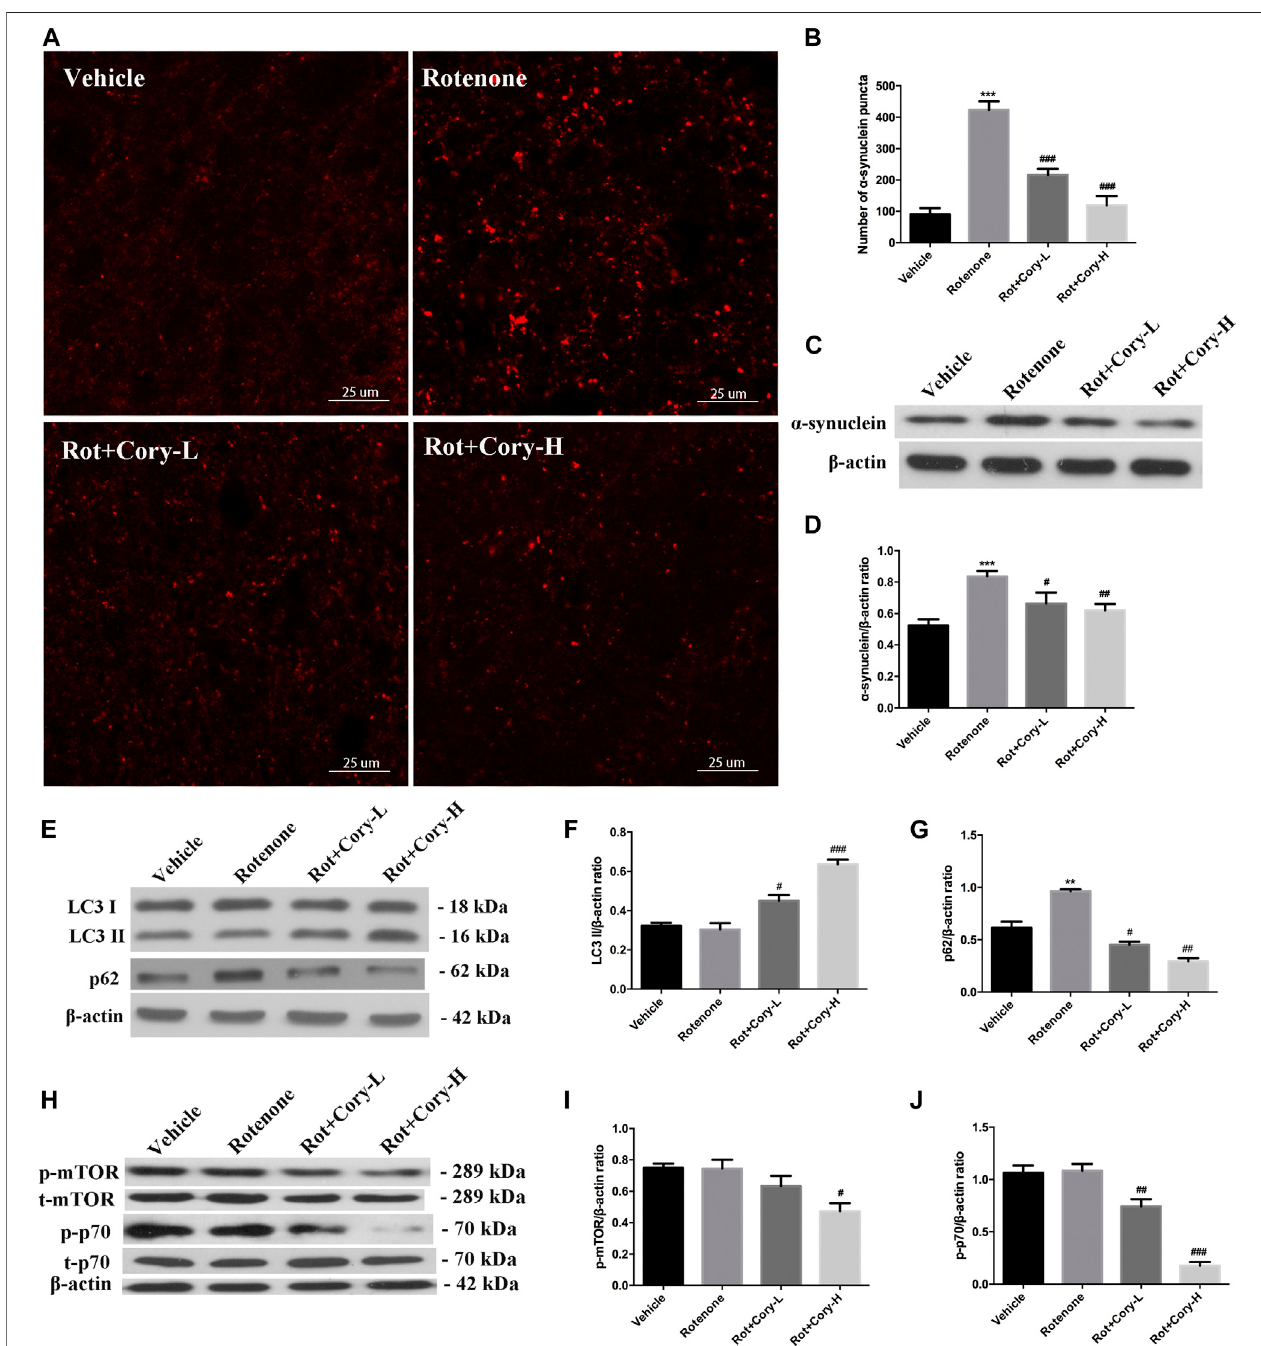
FIGURE 4 | Cory induces autophagy via the mTOR pathway and promotes the clearance of α -synuclein aggregation in the rotenone-induced rat model of PD. (A, B) Cory decreases the number of α -synuclein aggregations in the right side of SNpc. (C, D) Cory decreases α -synuclein expression in the right side of SNpc. The right side of SNpc was isolated from the brain tissue. After protein extraction, samples were subjected to Western blotting assay. (E – G) Cory increases LC3 II level and decreasesp62levelintherightsideofSNpc. (H – J) Corydecreasesp-mTORandp-p70levelsintherightsideofSNpc.TherightsideofSNpcwasisolatedfromthe brain tissue. After protein extraction, samples were subjected to Western blotting assay. Dosage of Cory in the rotenone-induced rat model of PD: Cory-L: 2.5 mg/kg, Cory-H: 5 mg/kg. Data were presented as mean ± SEM of three independent experiments. (*** p < 0.001 compared with Sham model, # p < 0.05, # p < 0.01, ### p < 0.001 compared with Rotenone group, one-way ANOVA with Newman-Keuls multiple test.)